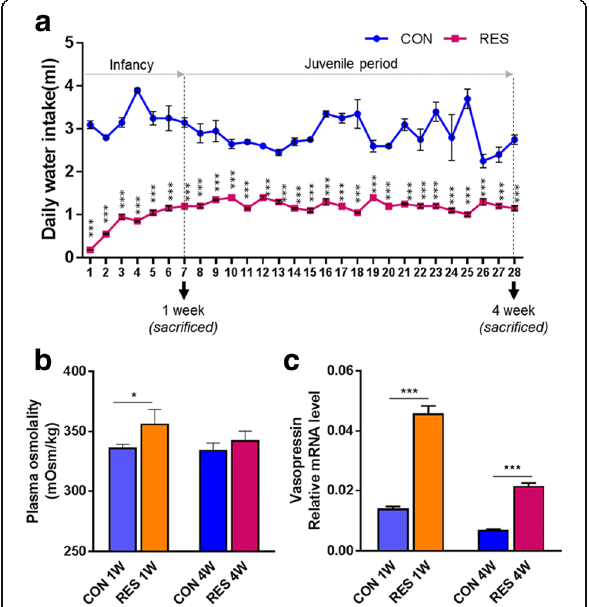
Fig. 2 Transcriptome profiling analysis of the kidneys in dehydrated and control mice using genome-scale Illumina microarray. a The weight of the kidney increased with age, but dehydration caused decreased weight in the kidneys of infant mice (RES 1W) by 22 % and in juvenile mice (RES 4W) by 8 %. b A 3D principal component analysis (PCA) plot of the renal transcriptome data represents significantly distinguishable profiles for each group: CON 1W ( light blue ), RES 1W ( orange ), CON 4W ( blue ), and RES 4W ( red ). Each dot indicates an individual kidney sample. c The Venn diagram shows the number of probes that were detected with different signal intensity in each dataset. Data are expressed as mean ± SEM. Student ’ s t test; ** p < 0.01, *** p < 0.001 versus control